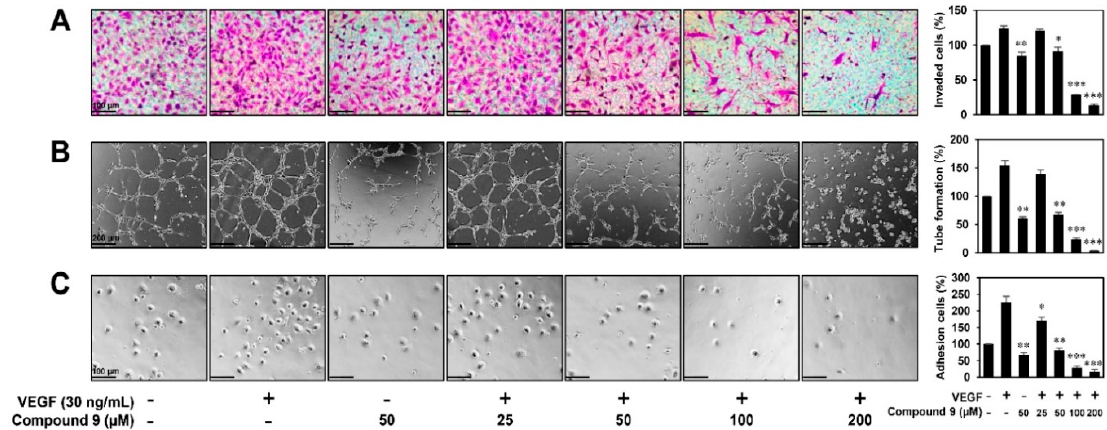
Figure 2. The in vitro antiangiogenic activity of compound 9 in HUVECs. ( A – C ) The inhibitory effects of compound 9 on the ( A ) invasion, ( B ) tube formation, and ( C ) adhesion of HUVECs induced by VEGF. Serum-starved HUVECs were stimulated with VEGF (30 ng/mL) in the presence or absence of compound 9 (25–200 µM). The basal levels of invasion, tube formation, and adhesion of HUVECs that were incubated in serum-free medium without VEGF were normalized to 100%. * p < 0.05, ** p < 0.01, *** p < 0.001 vs. the VEGF control. Each value represents the mean ± SD from three independent experiments.